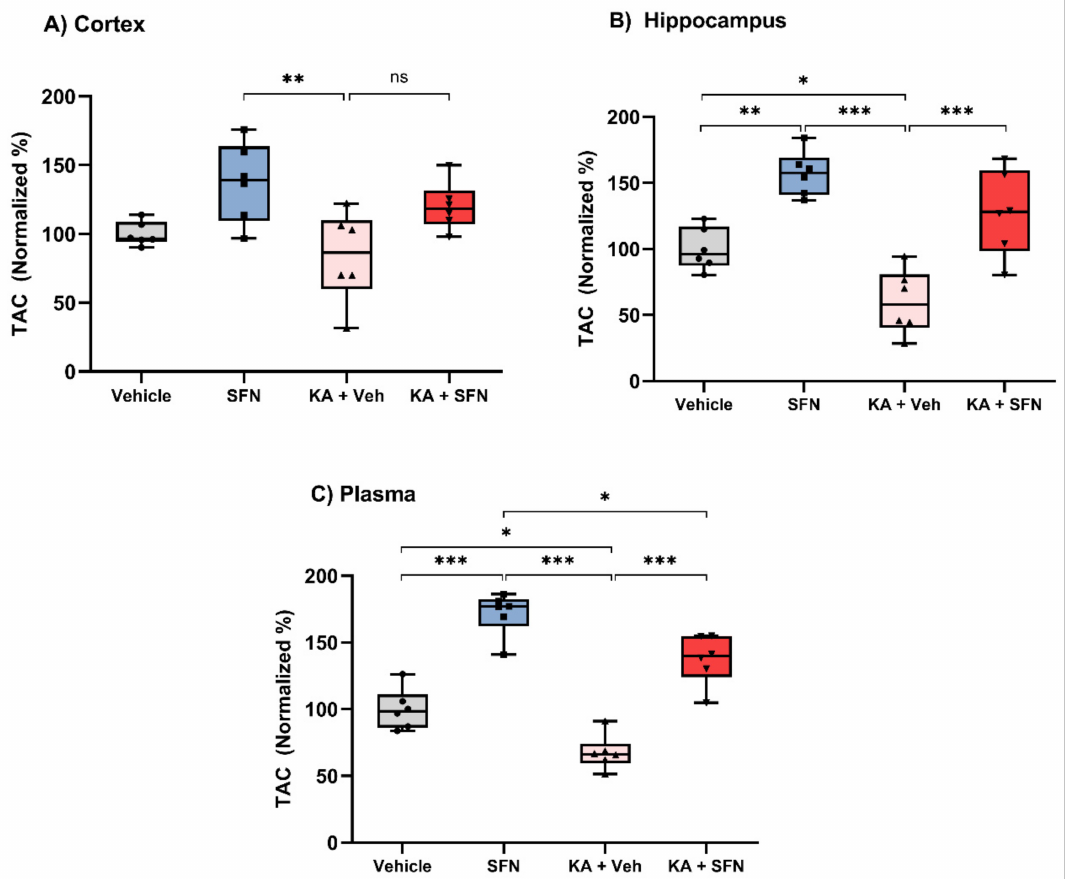
Figure 4. SFN increases total antioxidant capacity following SE. Total antioxidant capacity normalized to Trolox stan- dard in cortex (A), hippocampus (B) and plasma (C) of vehicle or SFN (5 mg/kg/day for 5 days) treated rats (no SE), and rats subjected to KA-SE and treated with SFN (5 mg/kg/day for 5 days) or equivalent volume and number of vehicle injections. ( A – C ): n = 6. Data are expressed as the mean ± SEM, (( A ): F (3, 20) = 5.673, p = 0.0056; ( B ): F (3, 20) = 18.68, p < 0.0001; ( C ): F (3, 20) = 48.56, p < 0.0001), one way-ANOVA followed by Tukey’s post hoc. * p < 0.05, ** p < 0.01, and *** p < 0.001 vs. KA + Vehicle group. n.s. p >